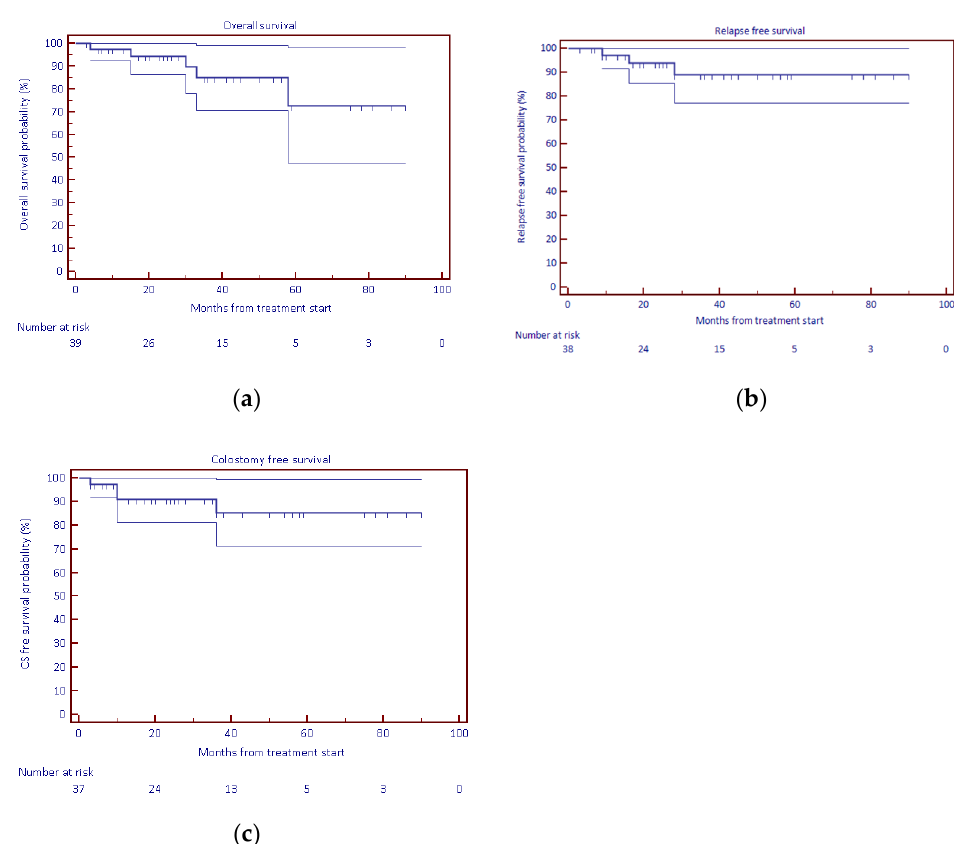
Figure 2. KM survival curves: ( a ) overall survival, ( b ) relapse-free survival, ( c ) colostomy-free survival.